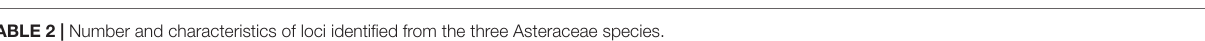
TABLE 2 | Number and characteristics of loci identified from the three Asteraceae